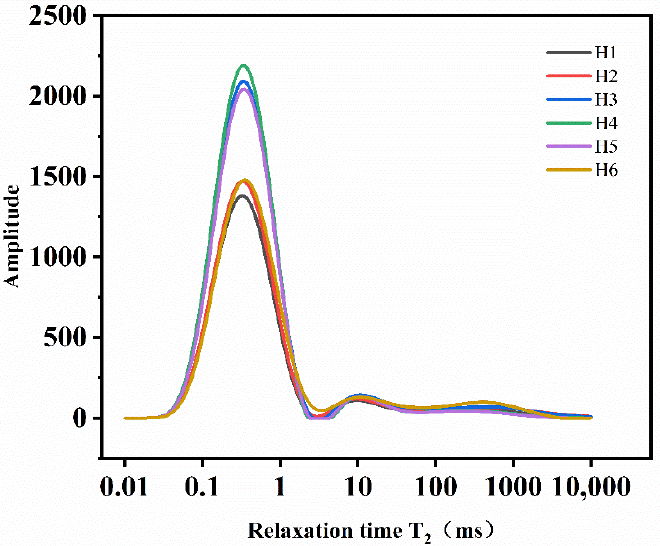
Figure 9. T 2 distribution curve of the NMR test (H1-H5 is the sample after 1500 salt freezing cycles under 5 erosion solutions, and H6 is the control sample without salt freezing cycles).